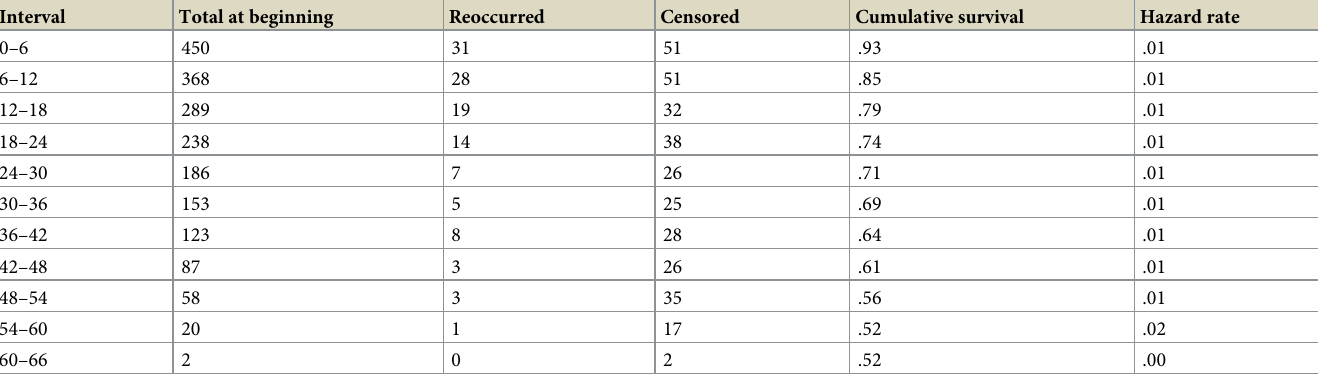
Table 1. Life table of cohort of HIV/AIDS patients attending follow-up at public health facilities in Arba Minch Town, Ethiopia.